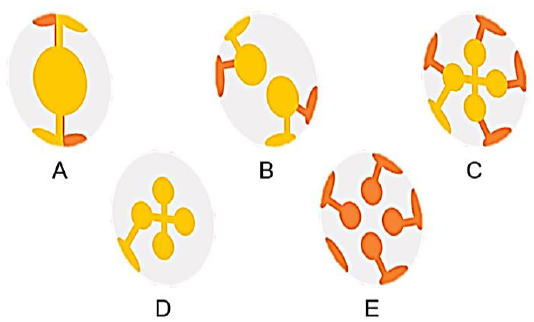
Figure 2. The design of quartz crystal microbalance (QCM) transducers: ( A ) A working single-electrode QCM for detecting a specific virus; ( B ) A dual-electrode QCM with working and reference electrodes for detecting a specific virus; and ( C ) A tetra-electrode QCM for simultaneous detection of multiple viruses. The front and back sides of the multichannel tetra-electrode QCM are shown in D and E, respectively. For sensor measurements, QCM is assembled into a flow cell so that its front side ( D ) is exposed to the liquid phase containing the target analyte (e.g., viruses), and its back side ( E ) is exposed to air to prevent damping of the sensor signal.